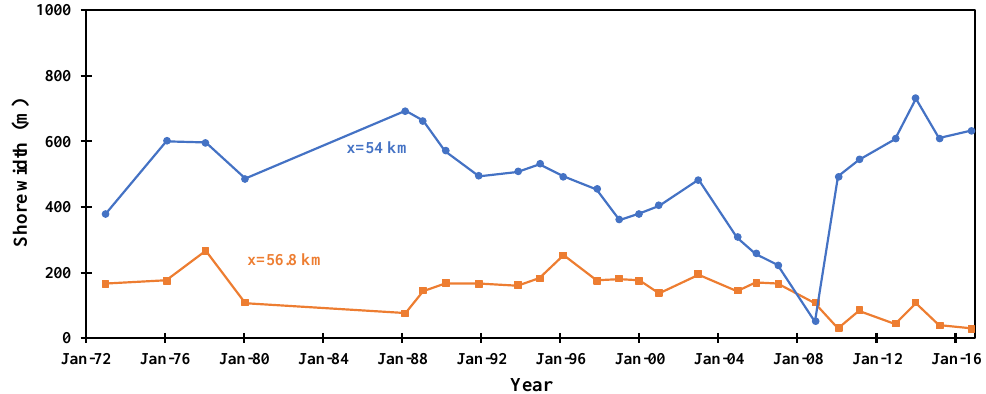
Figure 8. Variation in shore width in front of Marine Drive Road at x = 54 km and x = 56.8 km during 1972–2016.